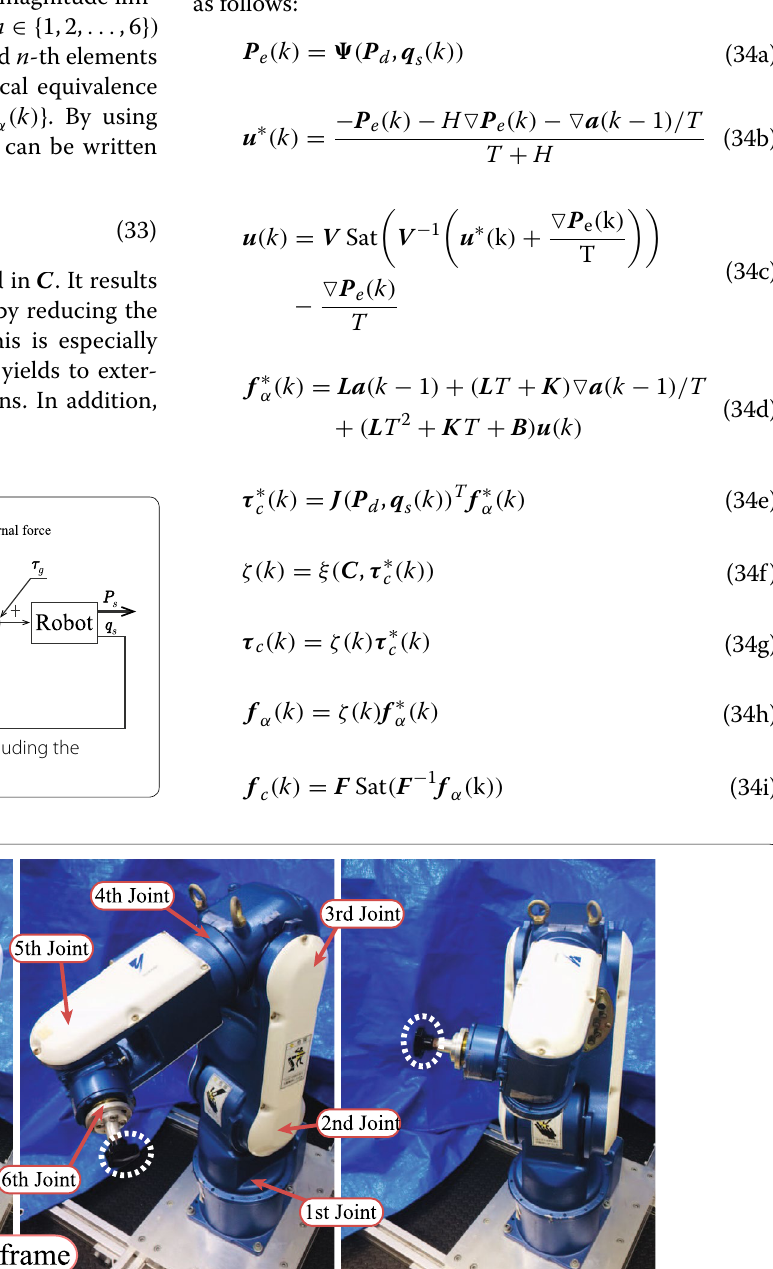
a b c Fig. 4 Six degree-of-freedom manipulator used in the experiments. Situations of Experiment I. a Configuration A ( p d = [ 0.26, − 0.01,0.52 ] T m , ˜ α d = [− 0.152,0.507, − 0.07 ] T ). b Configuration B ( p d = [ 0.31,0.02,0.45 ] T m , ˜ α d = [ 0.455,0.377,0.309 ] T ). c Configuration C ( p d = [ 0.23, − 0.06,0.54 ] T m , ˜ α d = [− 0.653,0.334, − 0.405 ] T